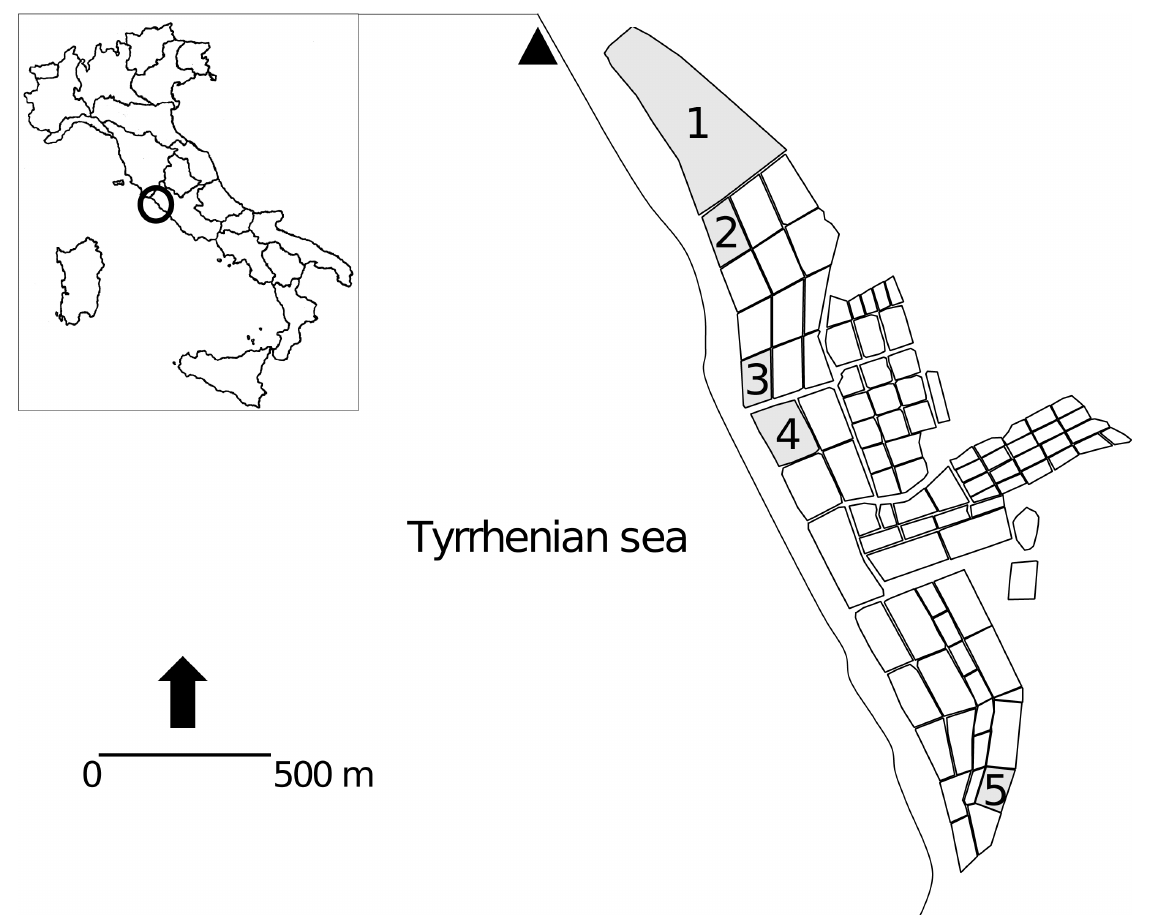
Figure 1. Geographic localization and spatial configuration of the study area, with the numbered gray areas representing the sampling stations. The black filled triangle is the point of water refill, which ensures the recycling of the water within the